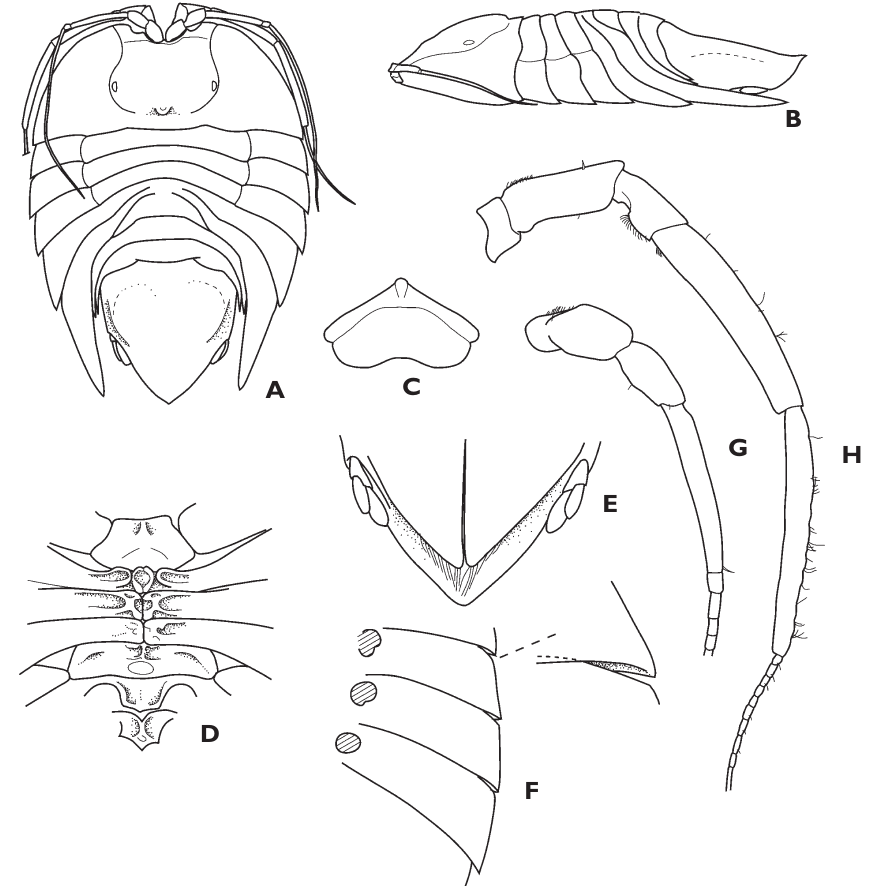
Figure 20. Myopiarolis systir sp. n. Holotype, except G, H, paratype ♂ 11.4 mm, Is.6013. A dorsal view B lateral view C frons (labrum and clypeus) D sternites and ventral pleonites E pleotelson, ventral view F coxae 2–5, ventral G antennule H